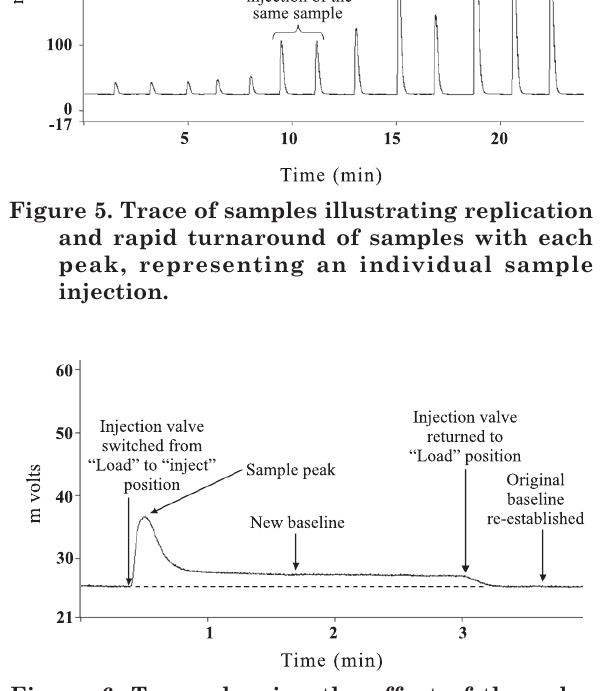
figure 6. trace showing the effect of the valve position on baseline detector